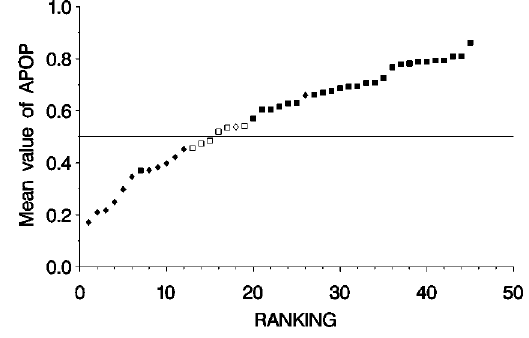
Fig. 3. Specimen classification results of WDNEC and SCLC ( (cid:4) SCLC cases, (cid:7) WDNECcases, open symbols:unclear decisions).